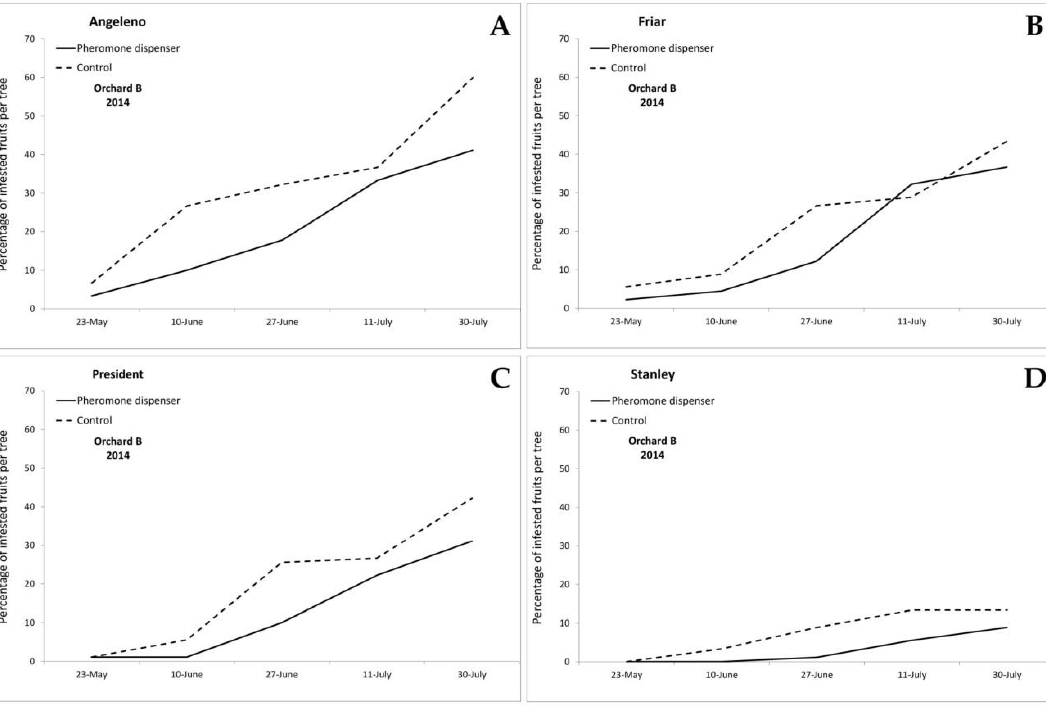
Figure 4. Infestation trend (mean percentage of infested fruits per tree) recorded in 2014 in Orchard B in the cultivars ( A ) Angeleno, ( B ) Friar, ( C ) President, and ( D ) Stanley.